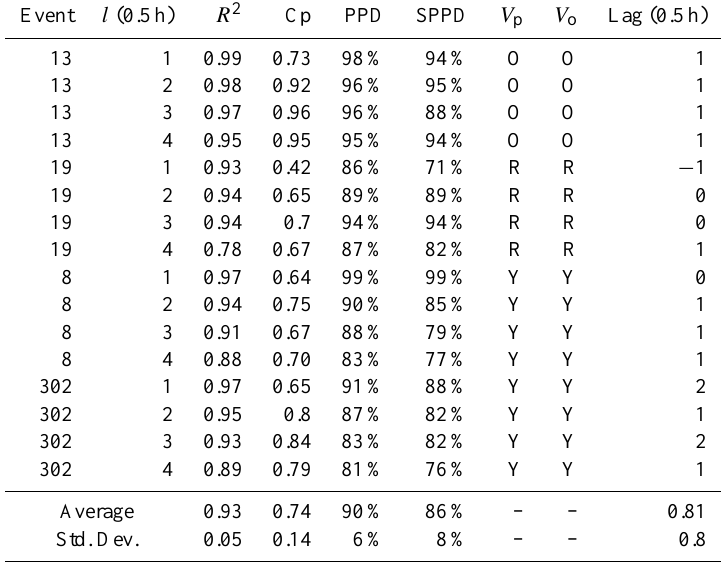
Table 6. Results obtained by the feedforward model ( V p : level of vigilance predicted by the model, V o : level of vigilance required given the observed discharge, Lag: delay between the maximum observed discharge and maximum forecast